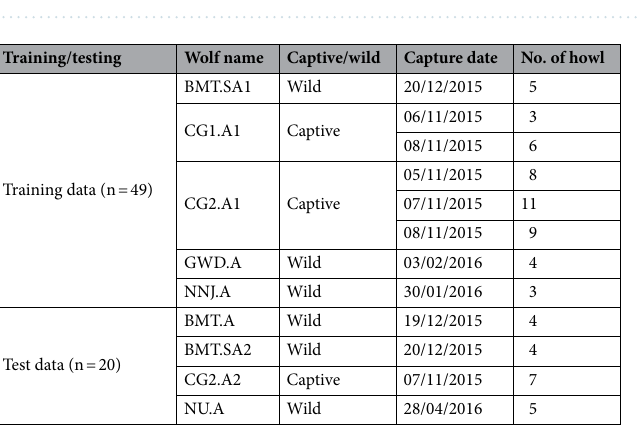
Figure 3. The pictorial representation of methodology for identifying unknown Indian wolves by their howls.